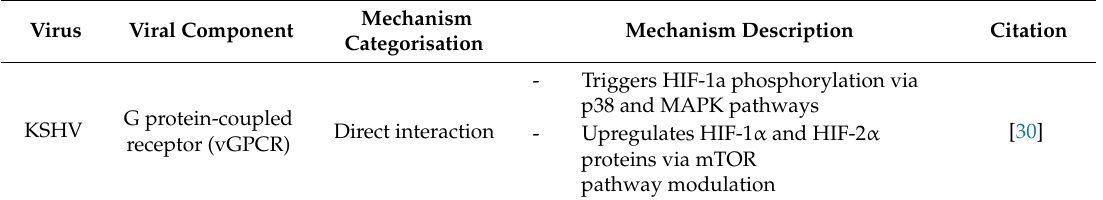
Table 1. Mechanisms in which viruses interact with